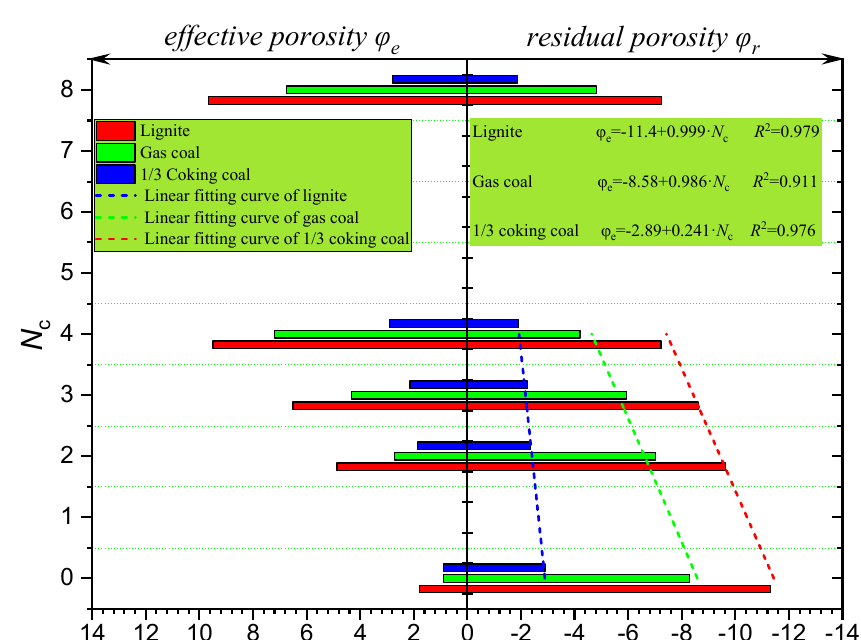
Figure 10. Variation in the effective porosity φ e and residual porosity φ r of the three coal